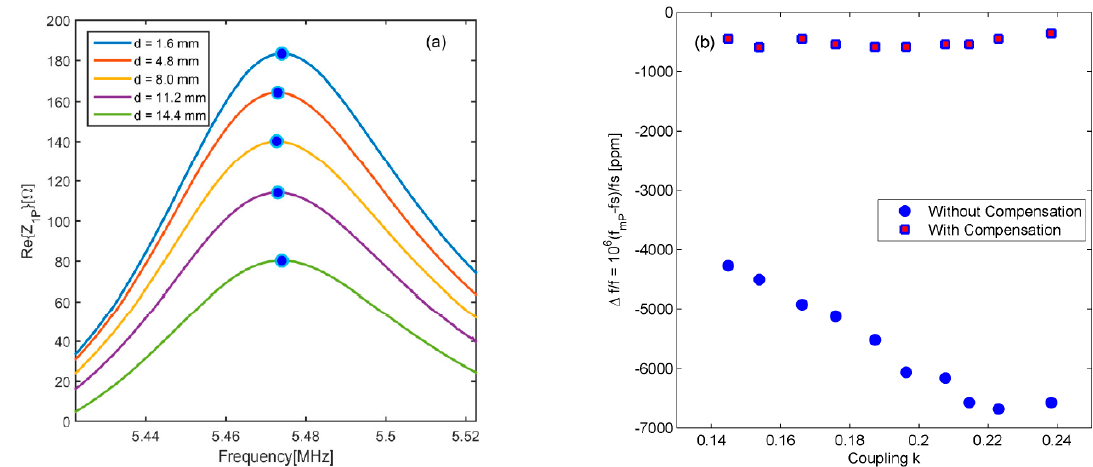
Figure 4. ( a ) Re{ Z 1 P } measured near f S for different values of the interrogation distance d considering a parasitic capacitance C P = 47 pF with the compensation circuit applied. ( b ) Comparison of the relative frequency deviation Δ f / f = 10 6 ( f mP − f S )/ f S with and without the compensation circuit